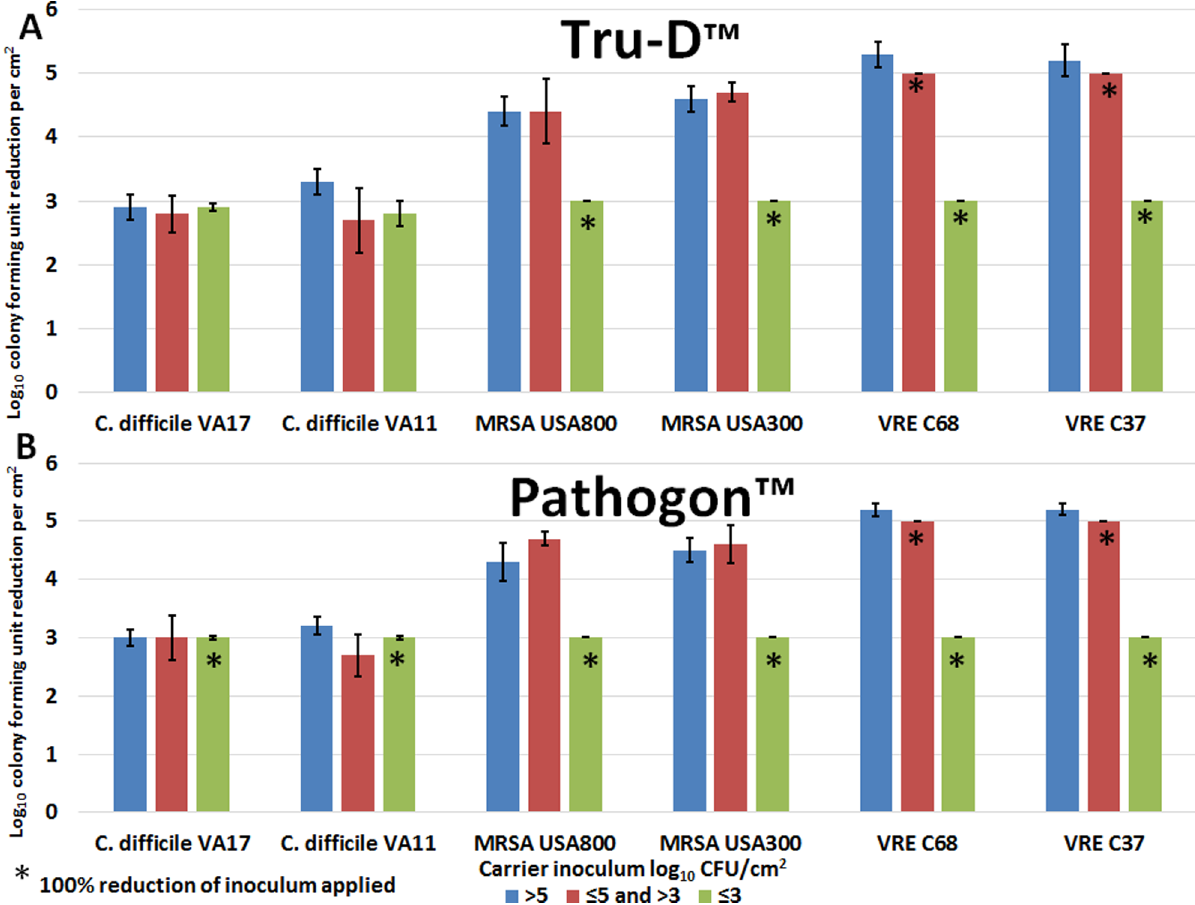
Figure 2. The effect of pathogen concentration on the efficacy of the UV-C devices. The log 10 CFU reduction/cm 2 of two strains of C. difficile spores, MRSA, and VRE inoculated onto carriers. Carriers contained either . 5, # 5 and . 3, or # 3 log 10 CFU of each pathogen. The carriers were irradiated for 41 minutes at a distance of 4 feet from the Tru-D (2A) or Pathogon (2B) device. The means of the data from experiments conducted in triplicate are presented. Error bars indicate standard